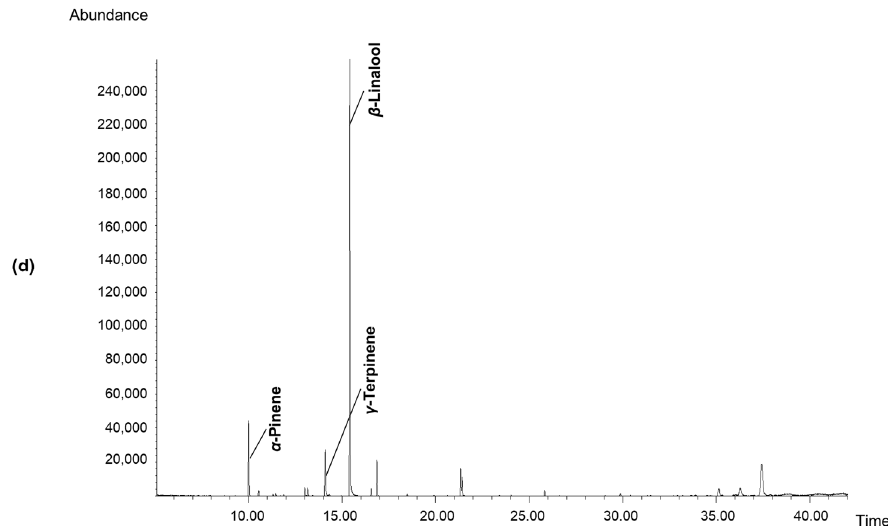
Figure 3. Chromatograms of volatiles in concretes obtained from two phenotypes of P. alkekengi fruit (PA-SB and PA-NB): ( a ) concrete from the peel of PA-SB phenotype; ( b ) concrete from the pulp of PA-SB phenotype; ( c ) concrete from the peel of PA-NB phenotype; ( d ) concrete from the pulp of PA-NB phenotype.